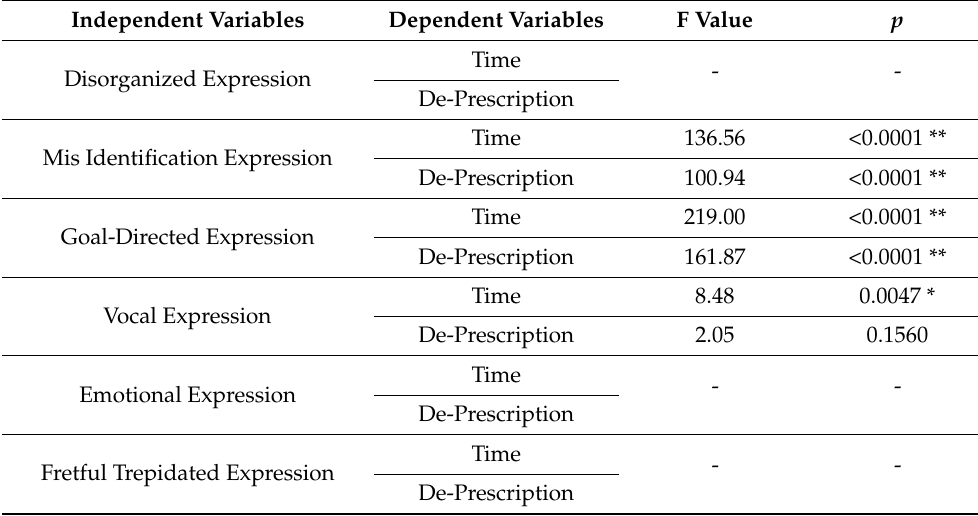
Table 5. MANOVA-Cross-Factoring of Time and De-Prescribing Results with Behavior Score. * means statistical significance with either time or de-prescribing, not both. ** means statistical significance with both time and